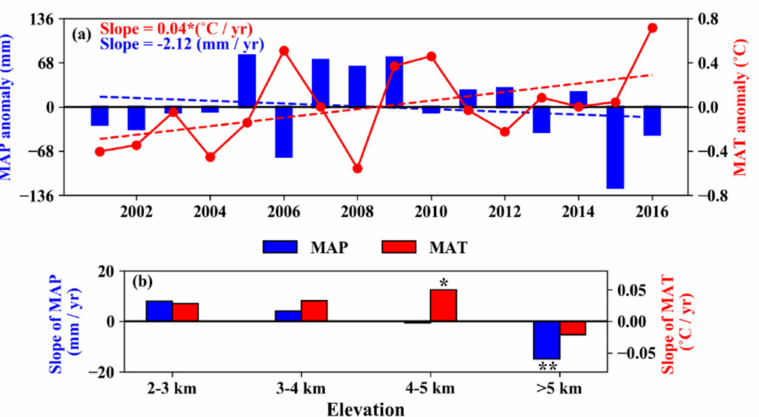
Figure 4. Trend of the mean annual temperature (MAT) and mean annual precipitation (MAP) anomaly ( a ) and their slope along the elevation gradient ( b ) in the TRSR from 2001 to 2016. * and ** denote that slope was statistically significant at the 0.05 and 0.01 level,